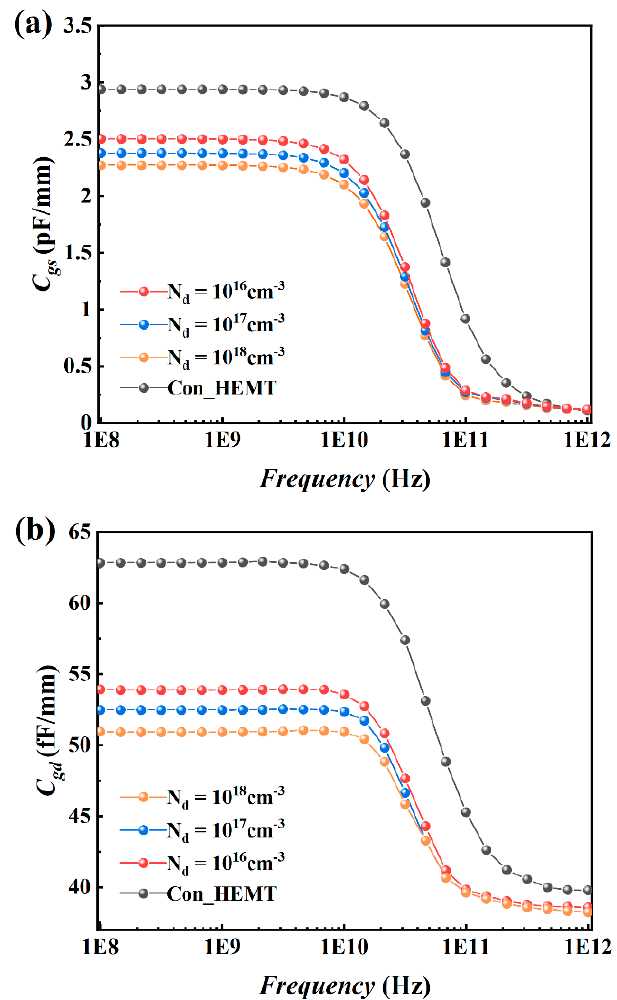
Figure 7. ( a ) C gs − F re q and ( b ) C gd − F req of the proposed structure with different doping concentration at V gs = 0 V and V ds = 20 V.